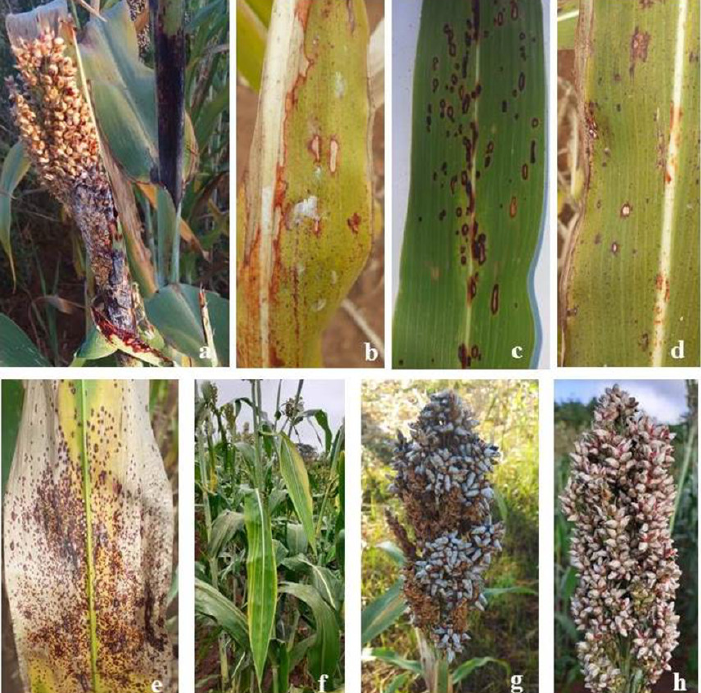
Figure 2. Fungal diseases observed in sorghum fields in different agro-ecological zones of lower eastern Kenya during the survey period. ( a ) Anthracnose disease symptoms on the leaf sheath and panicle parts; ( b ) leaf blight symptoms: long, elliptical, yellowish lesions on the leaf blade; ( c , d ) Alternaria leaf spot disease symptoms: oval, brown spots with whitish to yellowish center on the leaf blade; ( e )sorghum rust: rust pustules with red mass of spores on the leaf blade; ( f ) sorghum mildew ( Peronosclerospora spp.): yellow stripes running along the leaf blade; and ( g , h ) covered kernel smut ( Sporisorium sorghi ). Table 2. Foliar and panicle fungal disease prevalence observed in agro-ecological zones of lower eastern Kenya.